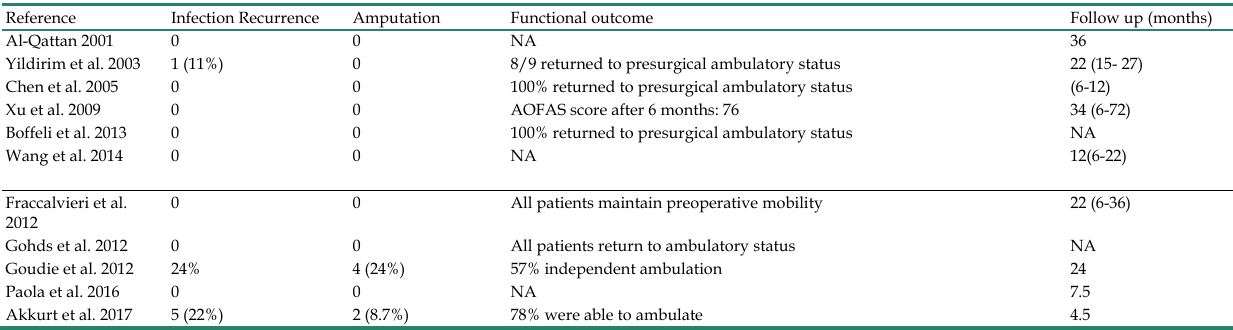
Table 3 : Systematic review of studies describing soft tissue treatment for calcaneal osteomyelitis. Treatment Reference